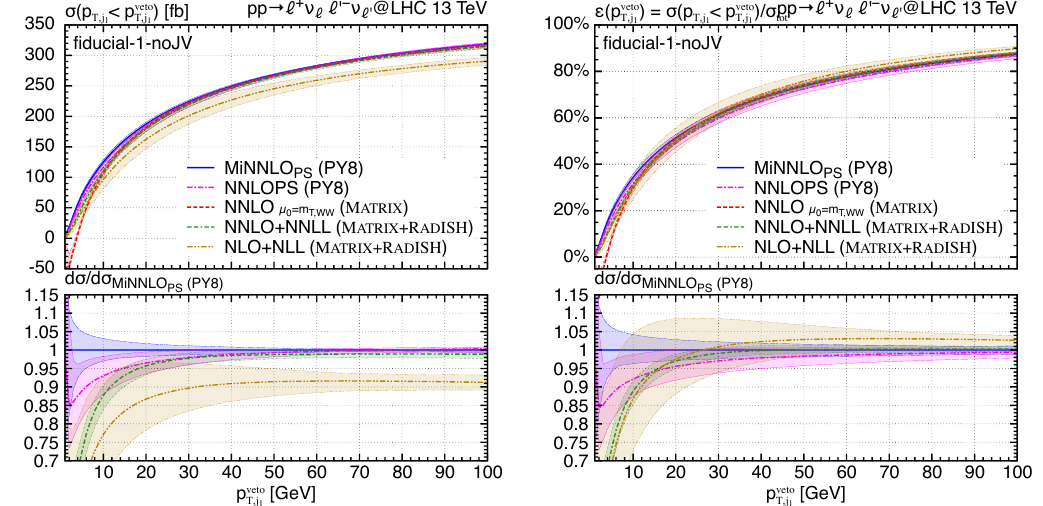
Jet-vetoed cross section (left plot) and jet-veto efficiency (right plot) in the fiducial-1-noJV phase